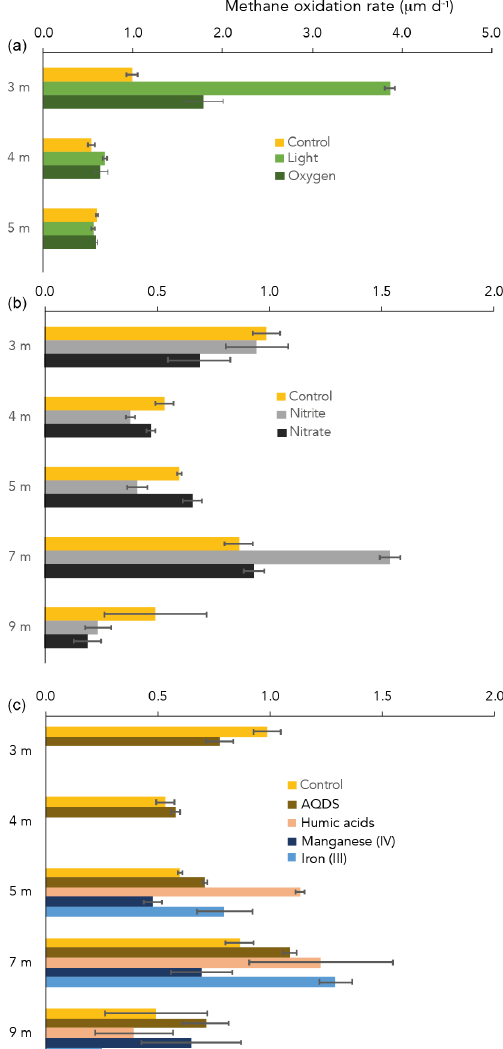
Figure 4. CH 4 oxidation rates in control and amended incubations, at different water depths. Note the different x axis in panel (a) vs. (b) and (c)